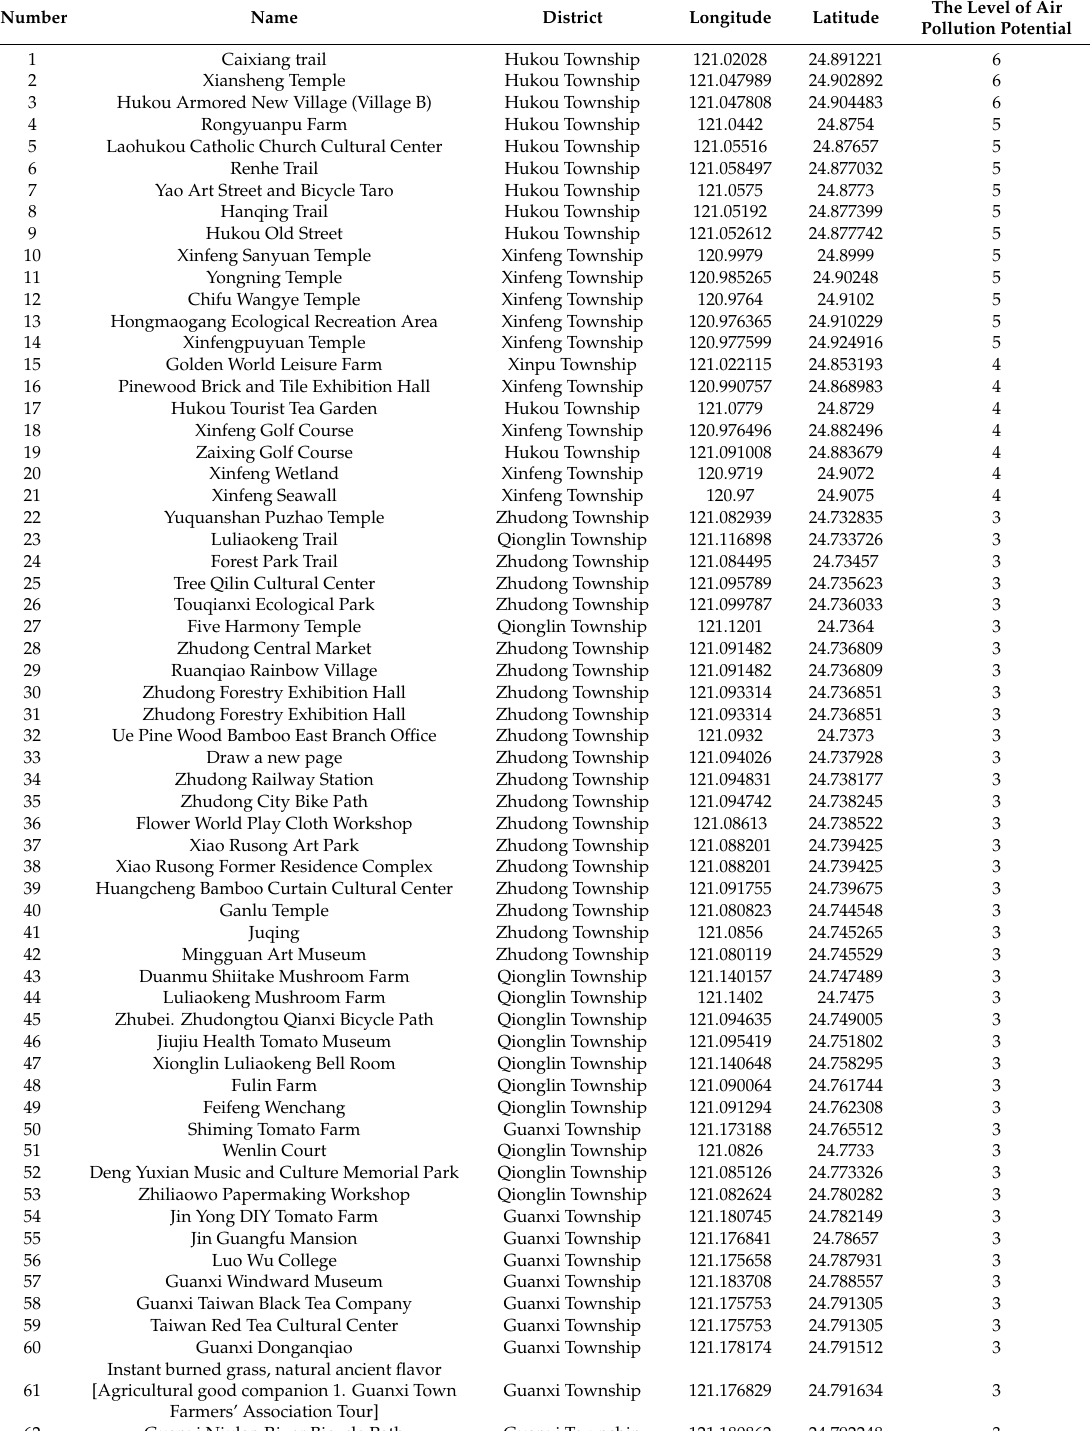
Table A1. Detailed air pollution potential of each tourist attraction in Hsinchu